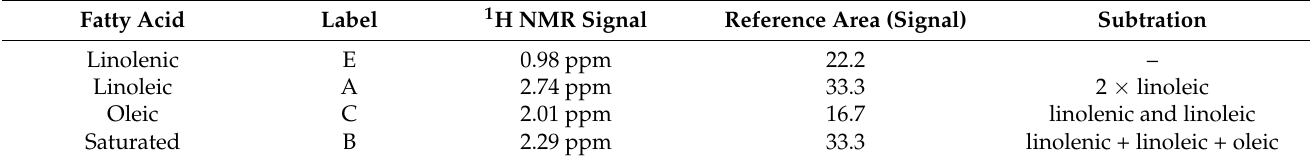
Table 6. Signal identification and quantification according to Barison’s